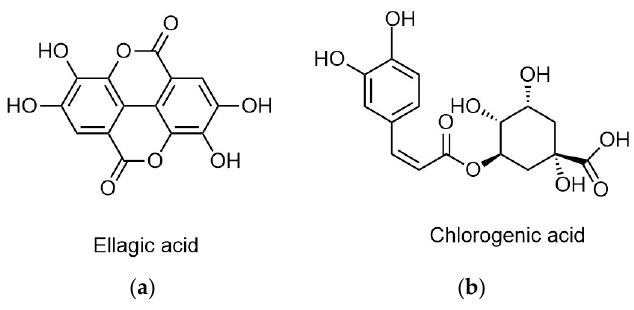
Figure 1. ( a ) Ellagic acid structure. ( b ) Chlorogenic acid structure. Figure 2. ( a ) Ellagic acid structure. ( b ) Chlorogenic acid structure.